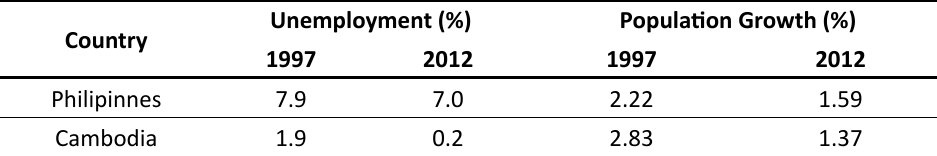
Table 2: Poverty in 5 ASEAN Countries 1997 - 2012 (%) Country